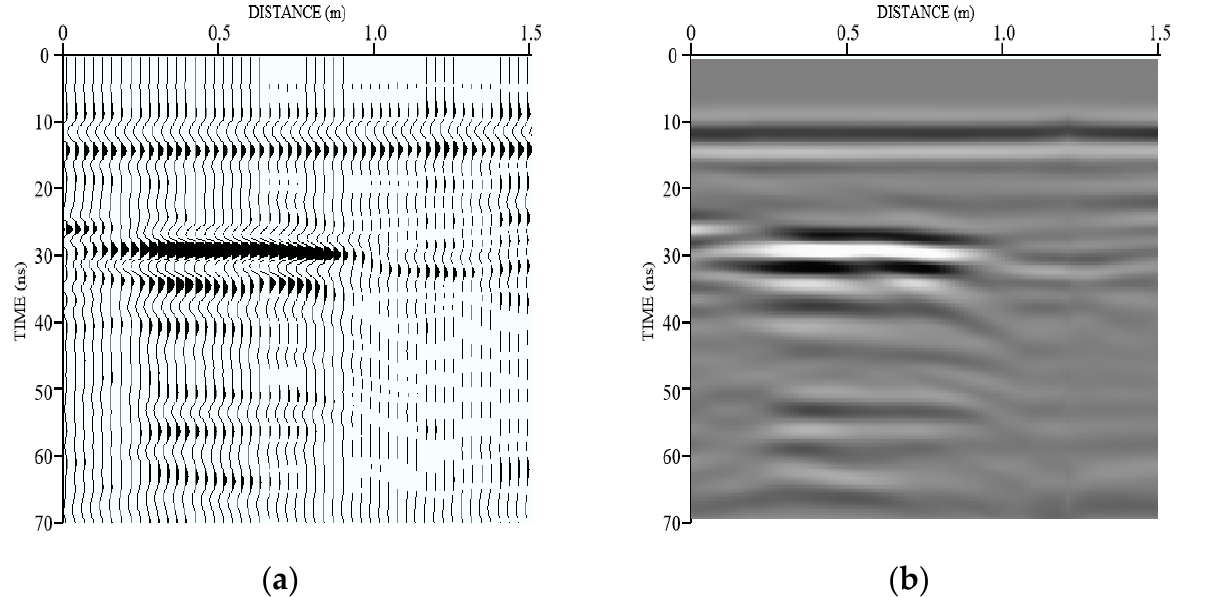
Figure 3. ( a ) Multiple A-scan traces along the survey line; ( b ) the GPR image in grayscale. Station spacing is the distance between each A-scan trace (also known as step size).